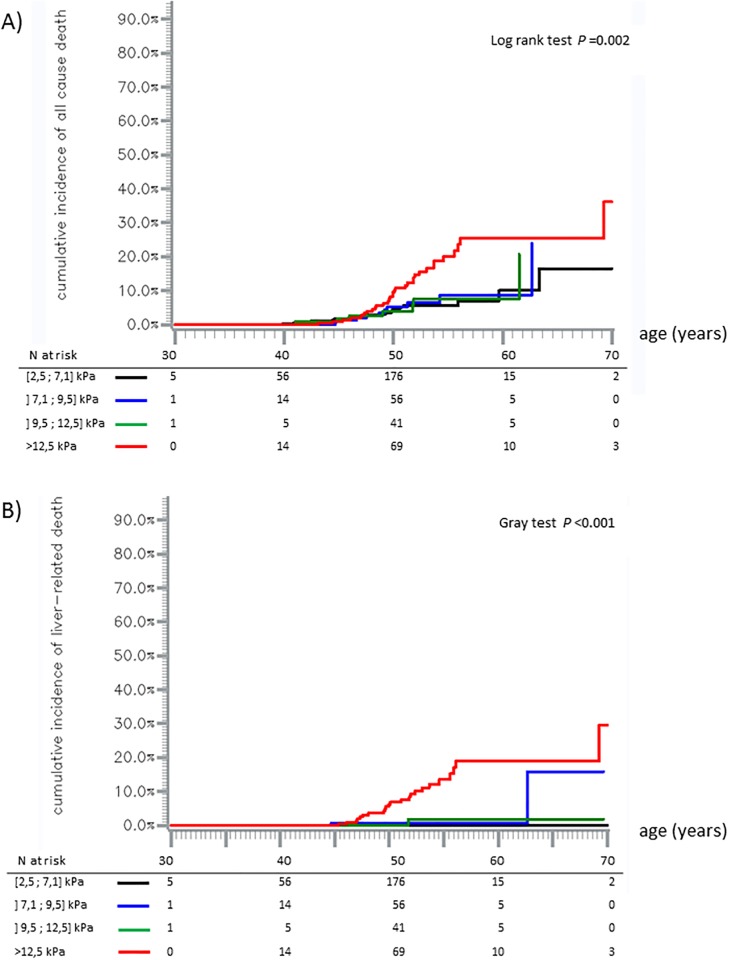
Cumulative incidence of all-cause, mortality (A) and liver-related mortality (B).Black line: LSM [2.5;7.1] kPa, blue line: LSM ]7.1;9.5] kPa, green line: LSM ]9.5;12.5] kPa, and red line: LSM >12.5 kPa. Kaplan-Meier method (A) and Aalen-Johansen method (B).